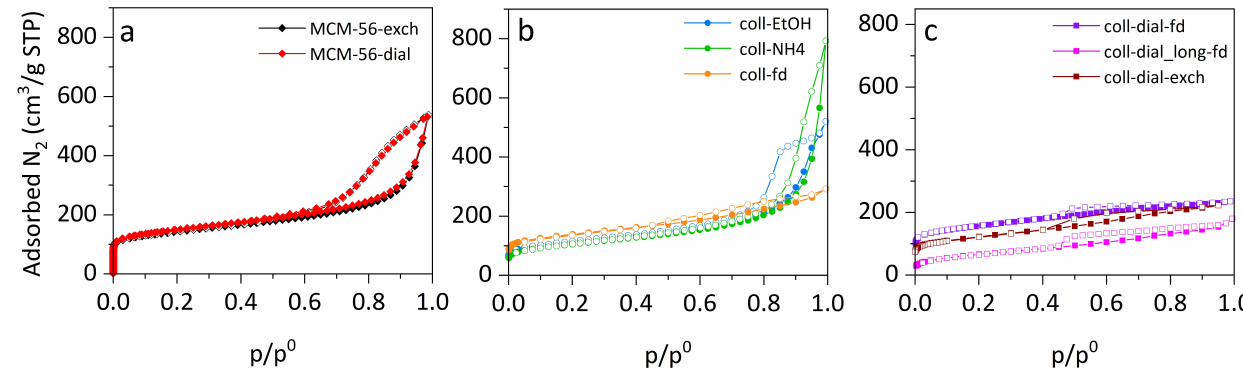
Figure 2. N 2 adsorption–desorption isotherms for zeolites under study: ( a ) MCM-56 ion-exchanged and dialyzed, ( b ) colloids precipitated with ethanol, ammonium nitrate and freeze-dried (lyophilized), ( c ) colloids purified by dialysis and subsequently precipitated. All samples were additionally calcined before the isotherm measurements. Table 1. Textural (specific surface area S BET , external surface S ext , micropore V micro and mesopore volumes V meso ), acidic (concentration of Brønsted acid sites BAS, external Brønsted acid sites BAS ext , and Lewis acid sites LAS) parameters, and catalytic performance in terms of the reaction half-time (t 1/2 ) and reaction constant (k) of zeolites under study.